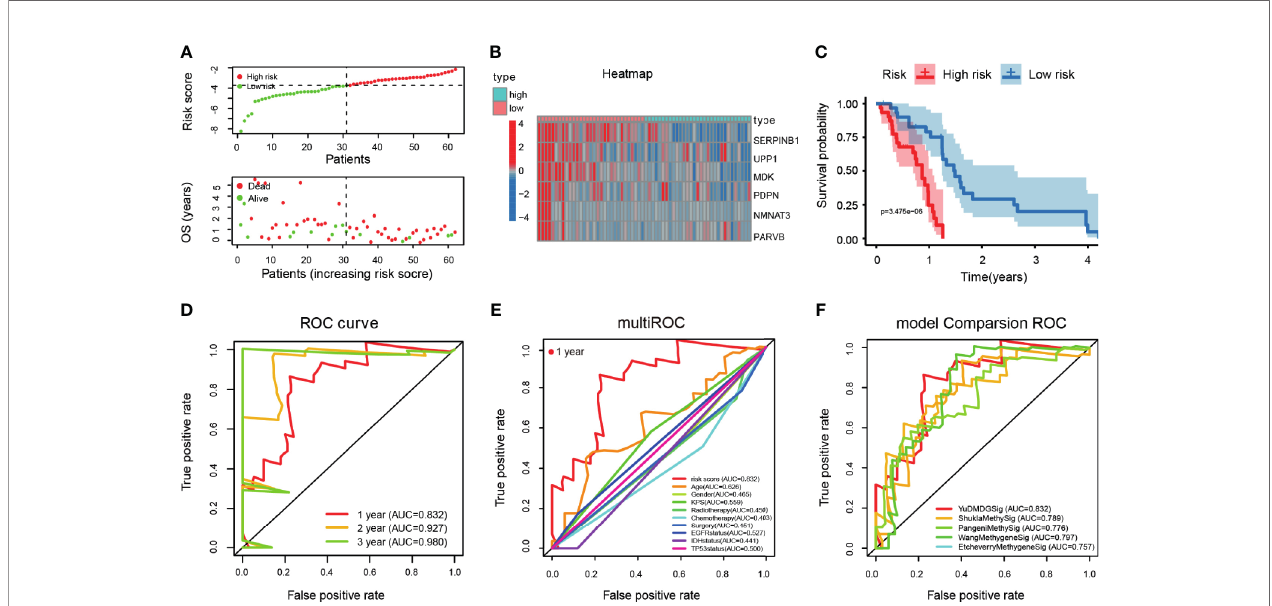
FIGURE 6 | Evaluation and comparison of DMDG prognostic model. (A) Risk score and survival status analysis of DMDG prognostic signature: the green dots represent low-risk patients and red dots represent high-risk patients. (B) The expression pattern of DMDG prognostic signature in the low- and high-risk groups. (C) Survival analysis of the two subgroups in DMDG prognostic signature. (D) ROC curve analysis for assessing the predictive power of the risk model within 1-, 2-, and 3-years. (E) Multivariate ROC curve analysis showing that the superior prognostic performance of the DMDG prognostic model compared to other clinical information within 1 year. (F) AUCs of the ROCs for our and the four other gene signatures within 1 year. The results demonstrate that the risk signature we constructed exhibits the most excellent predictive